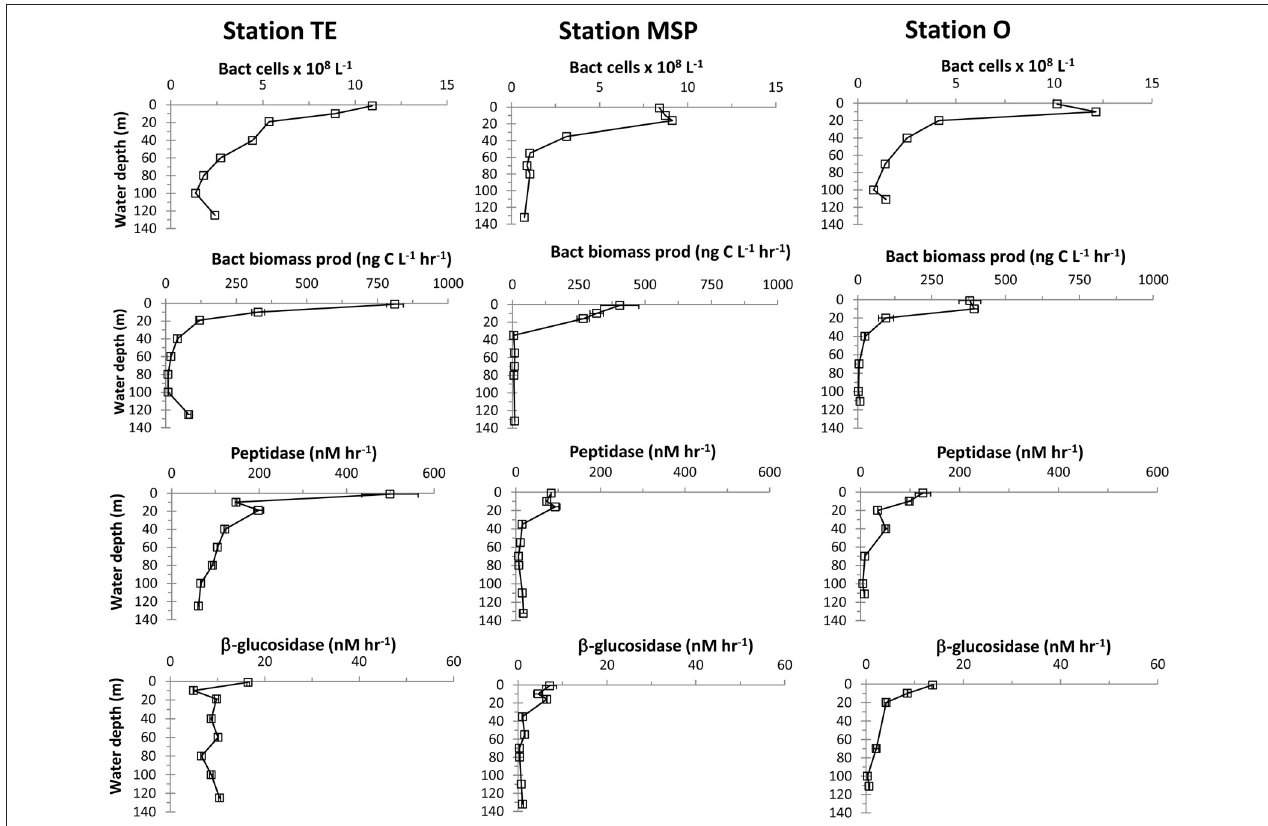
FIGURE 4 | Depth profiles of bacterial cell numbers, bacterial biomass production, and hydrolytic enzyme activities (peptidase and glucosidase). Error bars indicate standard deviations of average values.